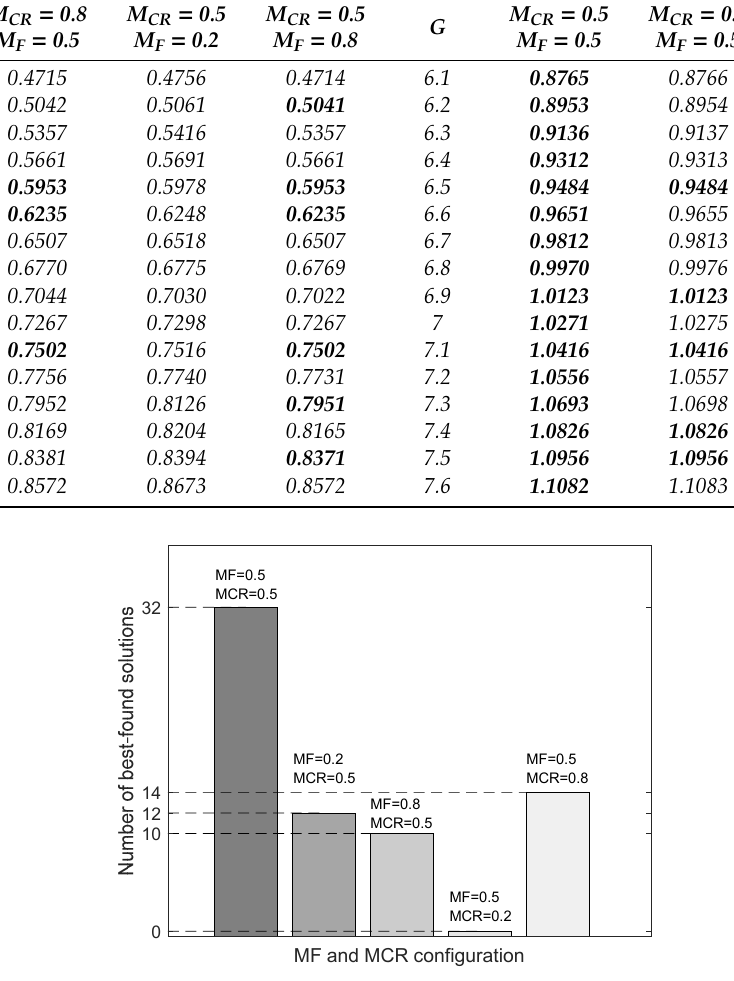
Figure 11. The number of best-found solutions for different M CR and M F values. In the penalty function, the constant factor w has also been tested using different values to select the best parameter. In this analysis, the factor w has been set to 1, 10, 20, 50, and 100 for the full operating range. The obtained results are listed in Table 3, in which the best outcomes are highlighted in boldface. Table 3. Comparative table of the obtained results using different values for the factor w . G